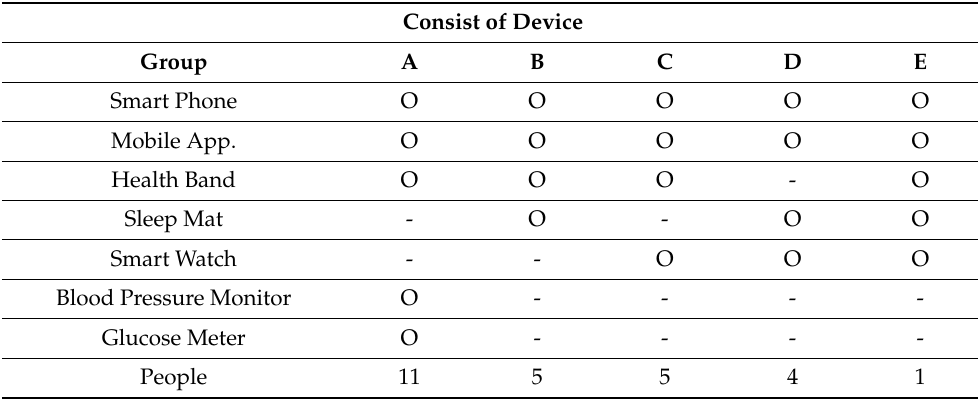
Table 1. Devices of healthcare